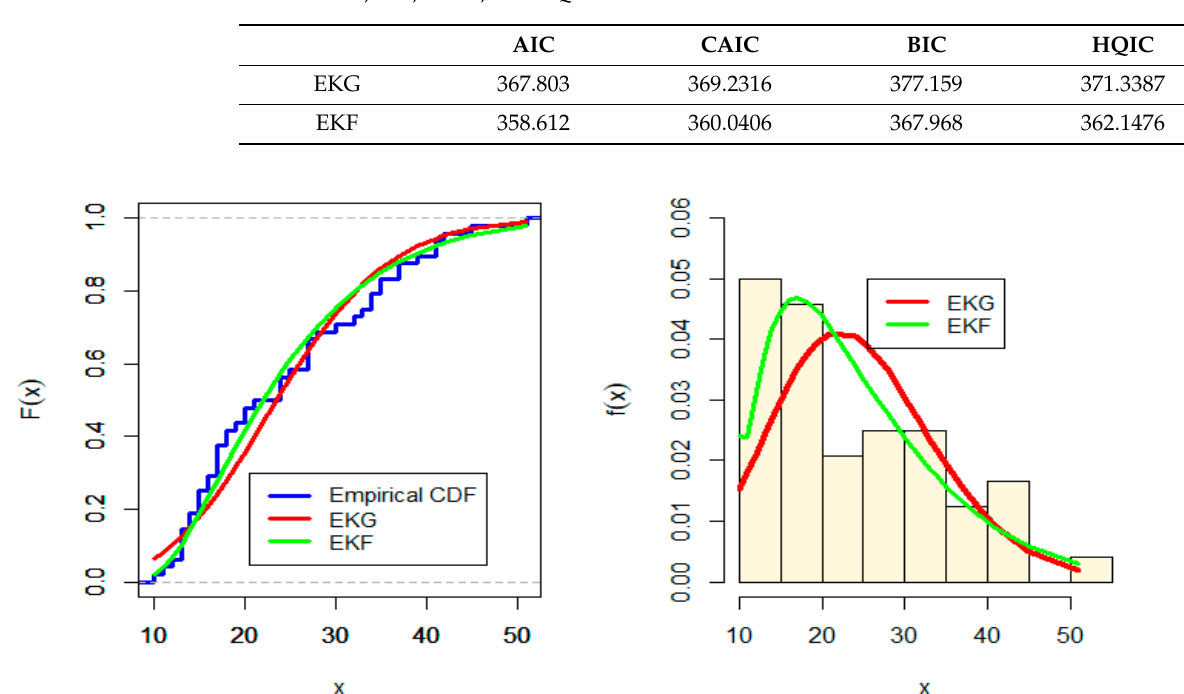
Figure 7. PP-plot for EKG and EGF distribution for Wire data. Table 9. AIC, BIC, CAIC, and HQIC for different sets and different model for Wire data. AIC 362.1476 Table 10. MLE and the Bayesian estimates for the fitted MEKGEF model for the Wire data. MLE